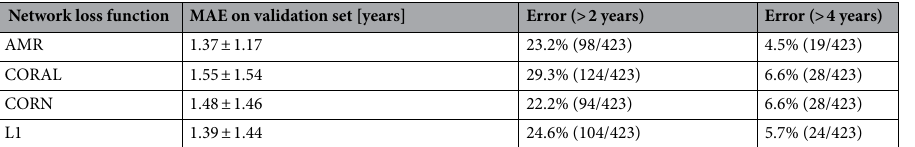
Table 2. Performance of the optimized networks in the validation set. Since AMR performed best in terms of MAE, it was chosen as final